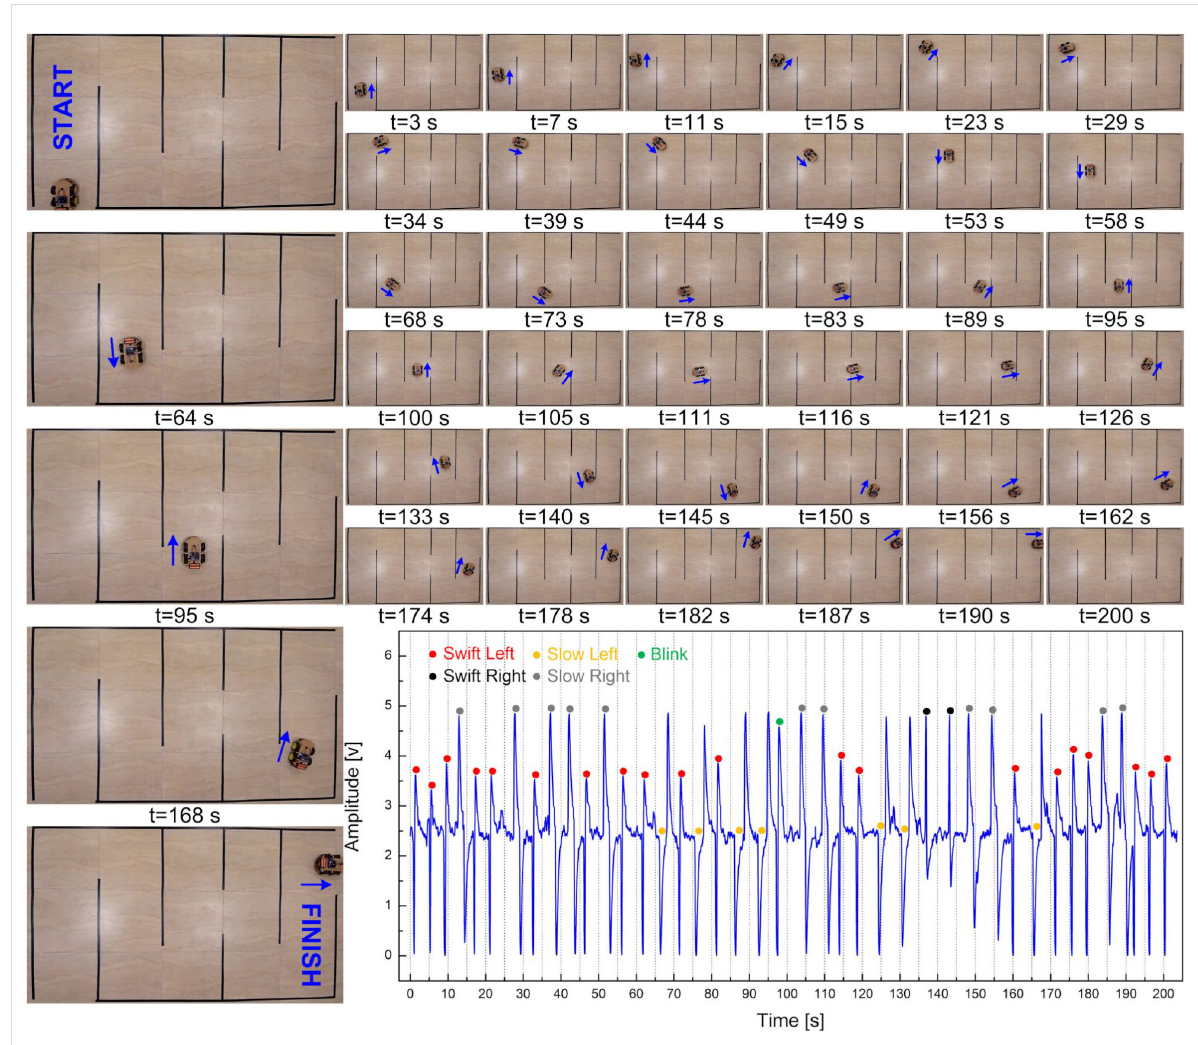
Figure 6: Snapshots of the robot car at different instances and plot of the recorded EOG trace during steering of the robot over a duration of more than 3 min with interpretations for the different eye movements (EMs) labeled in the waveform (video available in Supporting Information File 1).